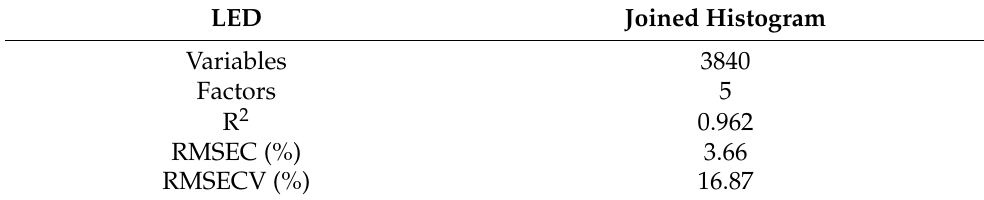
Table 5. Results obtained with all data. LED Joined Histogram Variables 3840